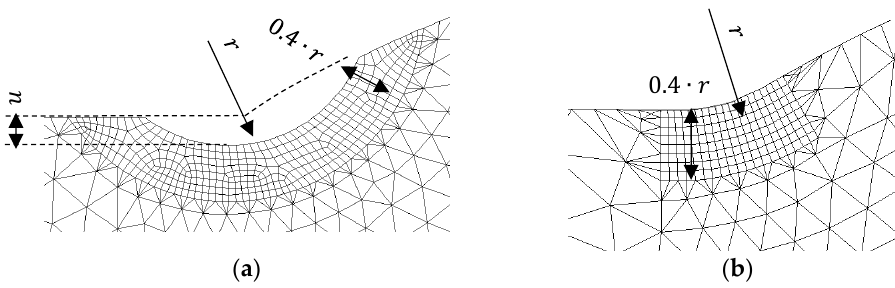
Figure 1. Butt joint geometry and loading conditions.